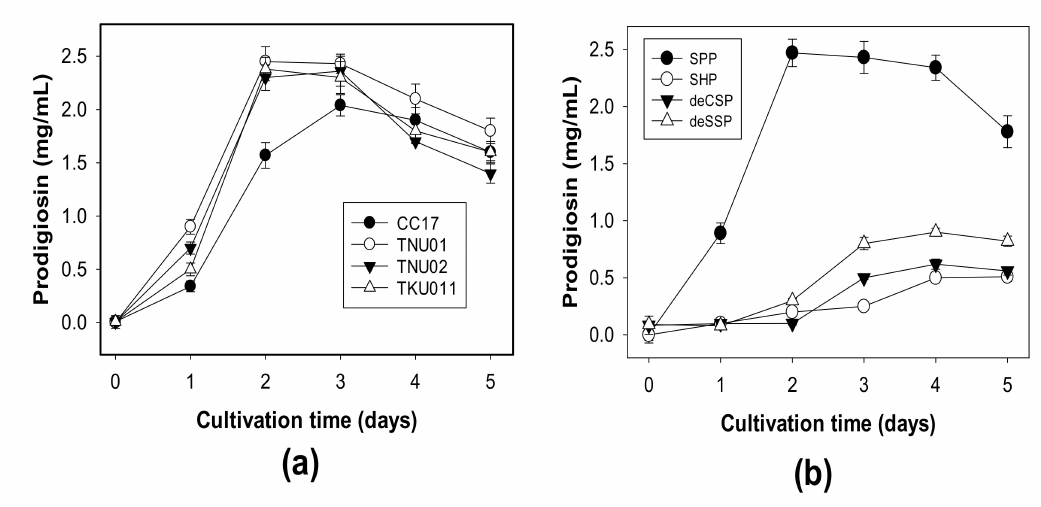
Figure 1. PG production by di ff erent S. marcescens strains, including S. marcescens TNU01, S. marcescens TNU02, S. marcescens CC17 and S. marcescens TKU011 ( a ), and the use of di ff erent chitin and protein–containing marine by–products for PG production by S. marcescens TNU01 ( b ). SPP: squid pens powder, SHP: shrimp head powder, deCSP: demineralized crab shells powder, deSSP: